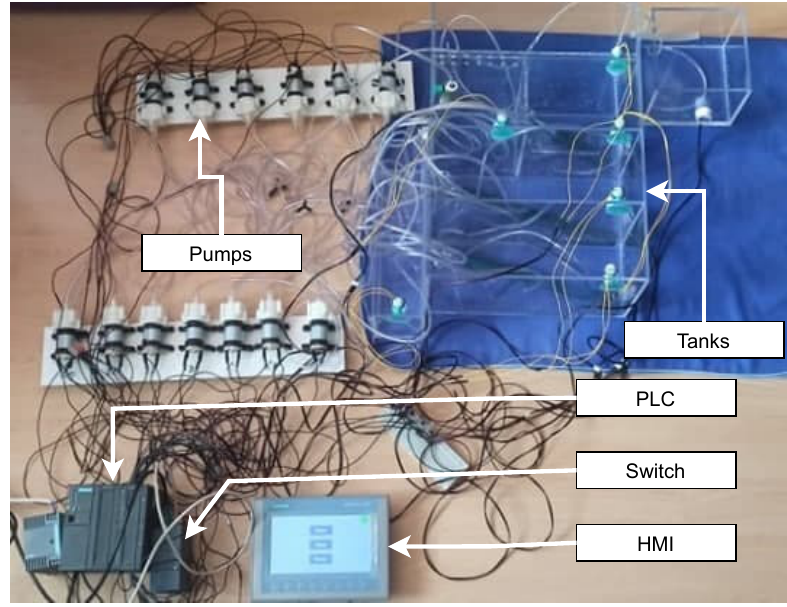
Figure 4. Wastewater treatment testbed.